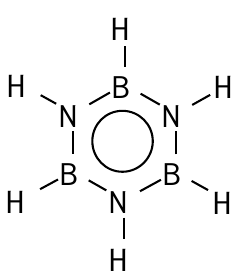
Figure 2. Borazine